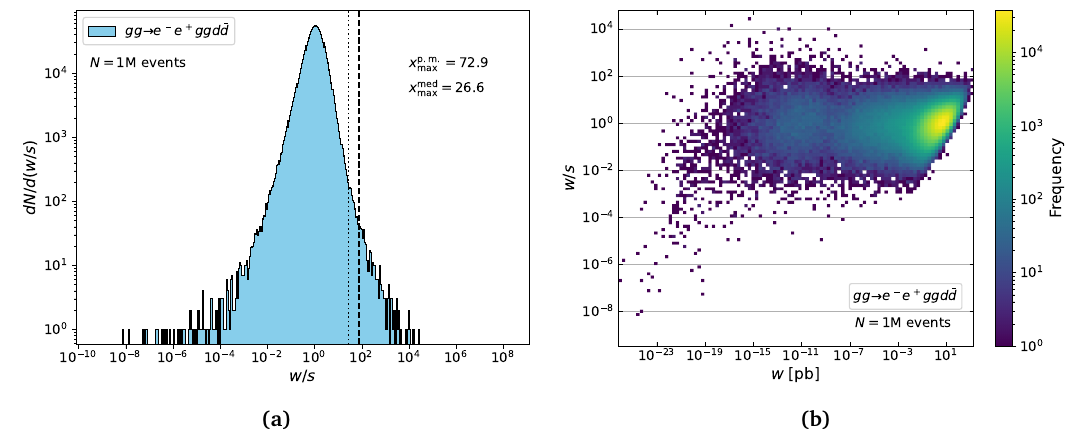
(cid:112) s = 13 TeV. (a) One- . The two vertical lines indicate the values of s (dashed) and x med (dotted). (b) Two-dimensional max max and the true event s